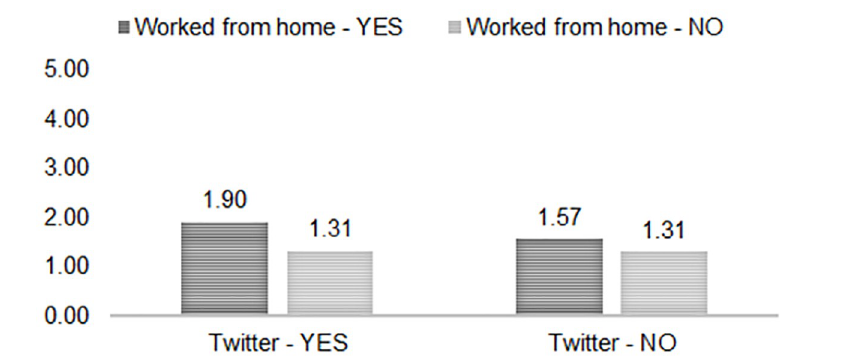
Fig 1. Twitter use by working/studying from home: Mean days drinking in past week.